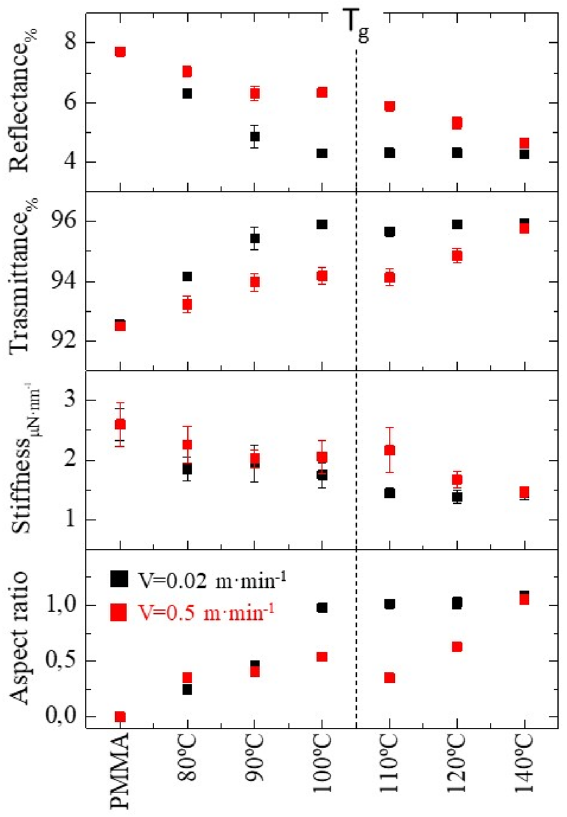
Figure 6. Summary of the R2R nanoimprinted moth-eye films characteristics related to topography aspect ratio, optical and mechanical performance as a function of the processing temperature obtained at web speed of 0.02 m·min −1 (black) and 0.5 m·min −1 (red). The data corresponding to the pristine PMMA film are included for comparison. The dotted line marks the PMMA T g